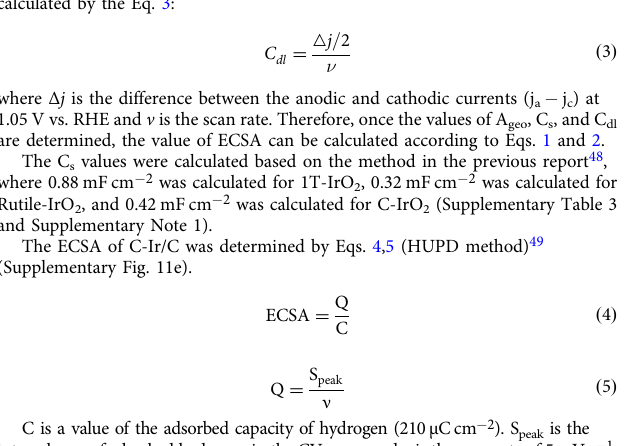
(Supplementary Fig. 11a – d and Supplementary Table 5): (cid:1) (cid:3) ¼ C dl R f Roughness factor C ð 2 Þ The electrochemical double-layer capacitance (C dl ) at non-Faradic potential range was obtained by measuring the capacitance of double layer at solid-liquid interface employing cyclic voltammetry (CV) with different scan rates (5, 10, 15, 20, 25, 30, and 35mV s − 1 ) in a range from 1.0 and 1.1V vs. RHE. The C dl was calculated by the Eq.